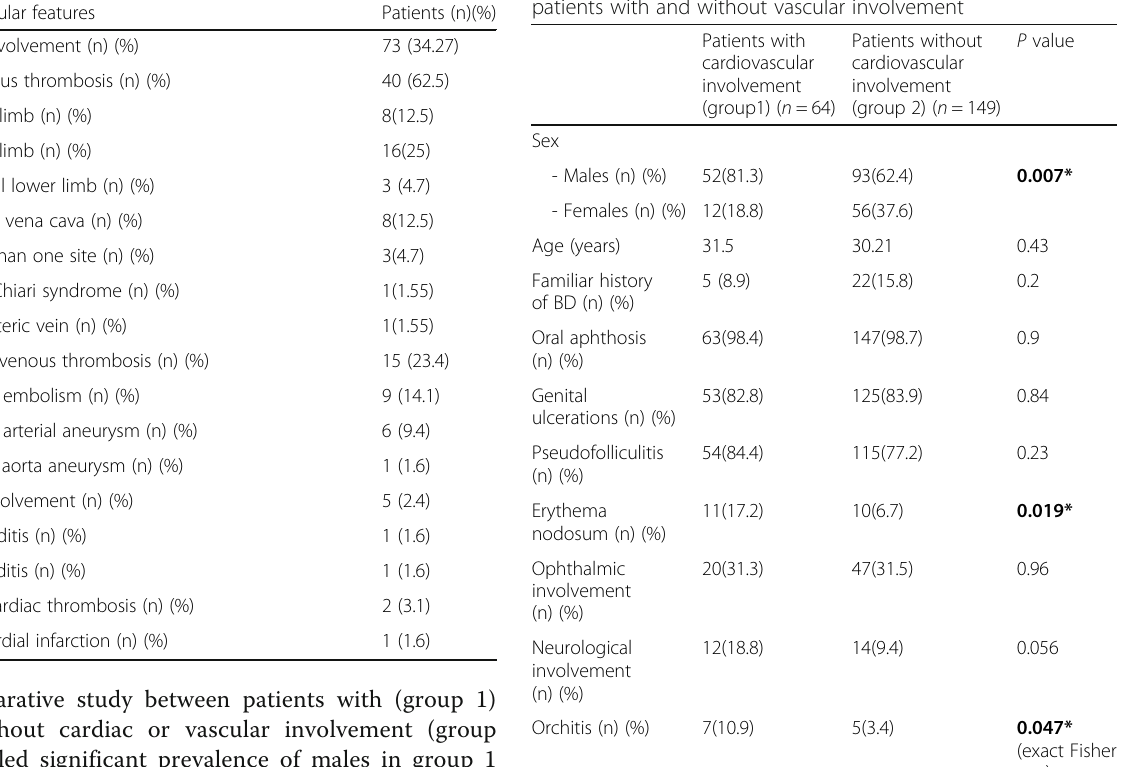
Table 3 Comparison of clinical features in Behçet Disease patients with and without vascular involvement